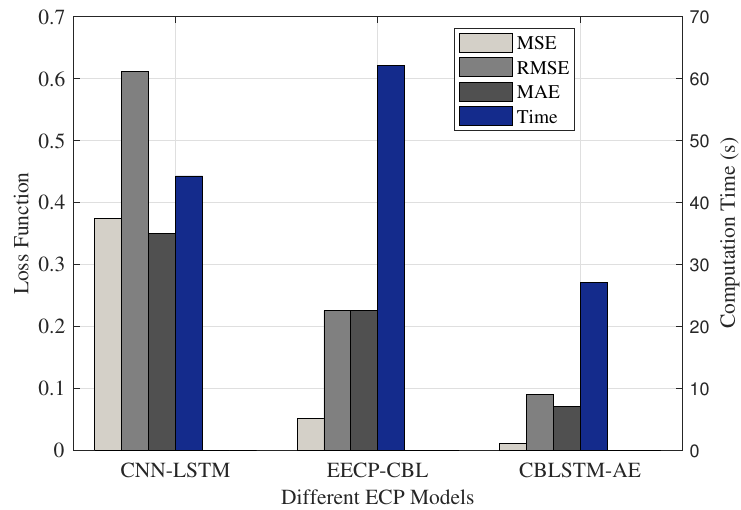
Figure 4. Performance comparison to other frameworks for daily data.